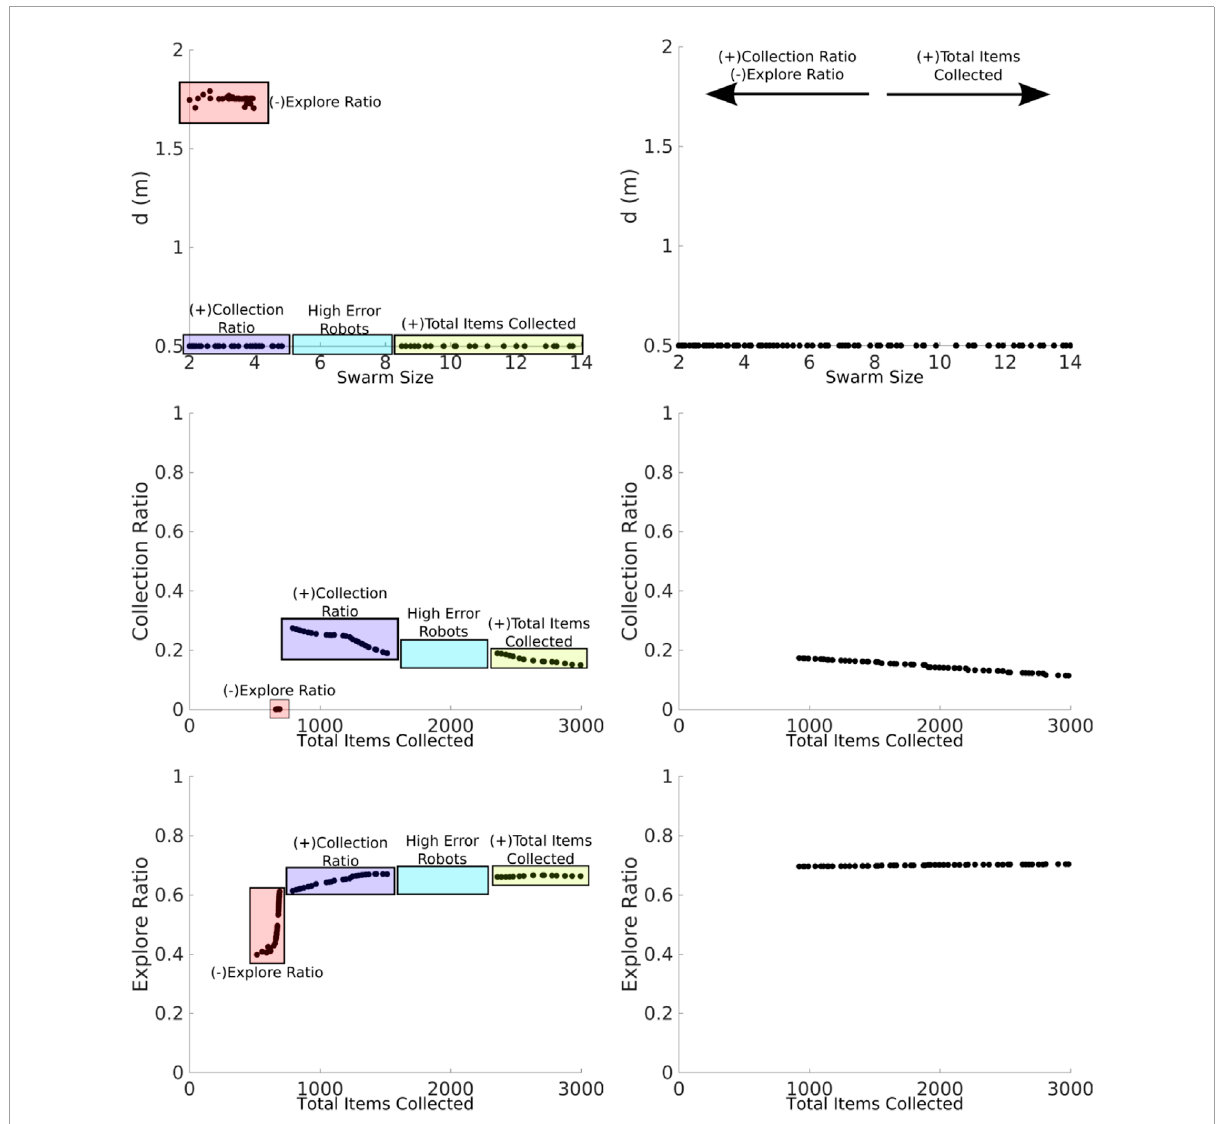
FIGURE 9 NSGA-II results for the NPS with heterogeneous (left column) and homogeneous (right column) errors. The two-dimensional inputs are swarm size—d (top row). Two-dimensional outputs are shown as total items collected—collection ratio (middle row) and total items collected—explore ratio (bottom row). With both the heterogeneous error and the homogeneous error, the total items collected are maximized with high swarm sizes (yellow box). With both the heterogeneous error and the homogeneous error, the collection ratio is maximized with low swarm sizes (blue rectangles). The explore ratio is maximized with low swarm sizes and high d for the heterogeneous error and low swarm sizes and low d for the homogeneous error. The latter result demonstrates that since this proportion of robots experiences a low error, it is better for these robots to travel a longer d , and as the robot density is lower, the robots spend less time avoiding each other. The Pareto front is discontinuous for the heterogeneous error which means that these robots with high-error rates harm the item collection than they contribute to